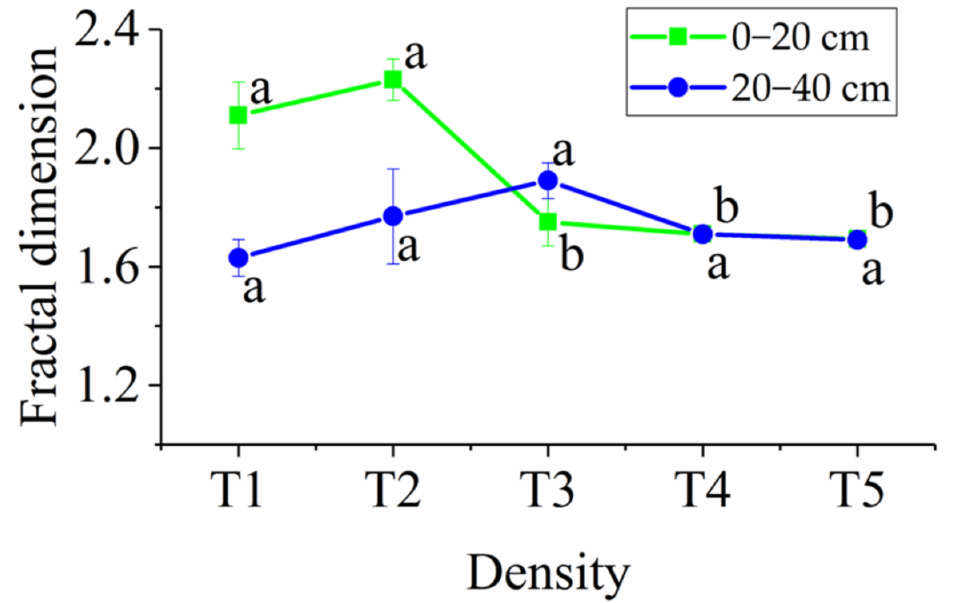
Figure 6. Soil fractal dimensions in the 0–20 and 20–40 cm soil layers under the five densities. The different letters for each line denote the significant differences ( p < 0.05) among the five